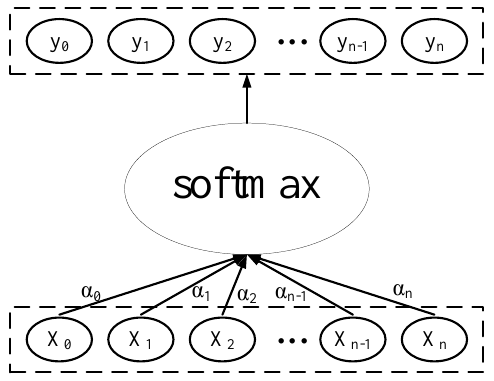
Figure 2. Schematic diagram of the attention mechanism.